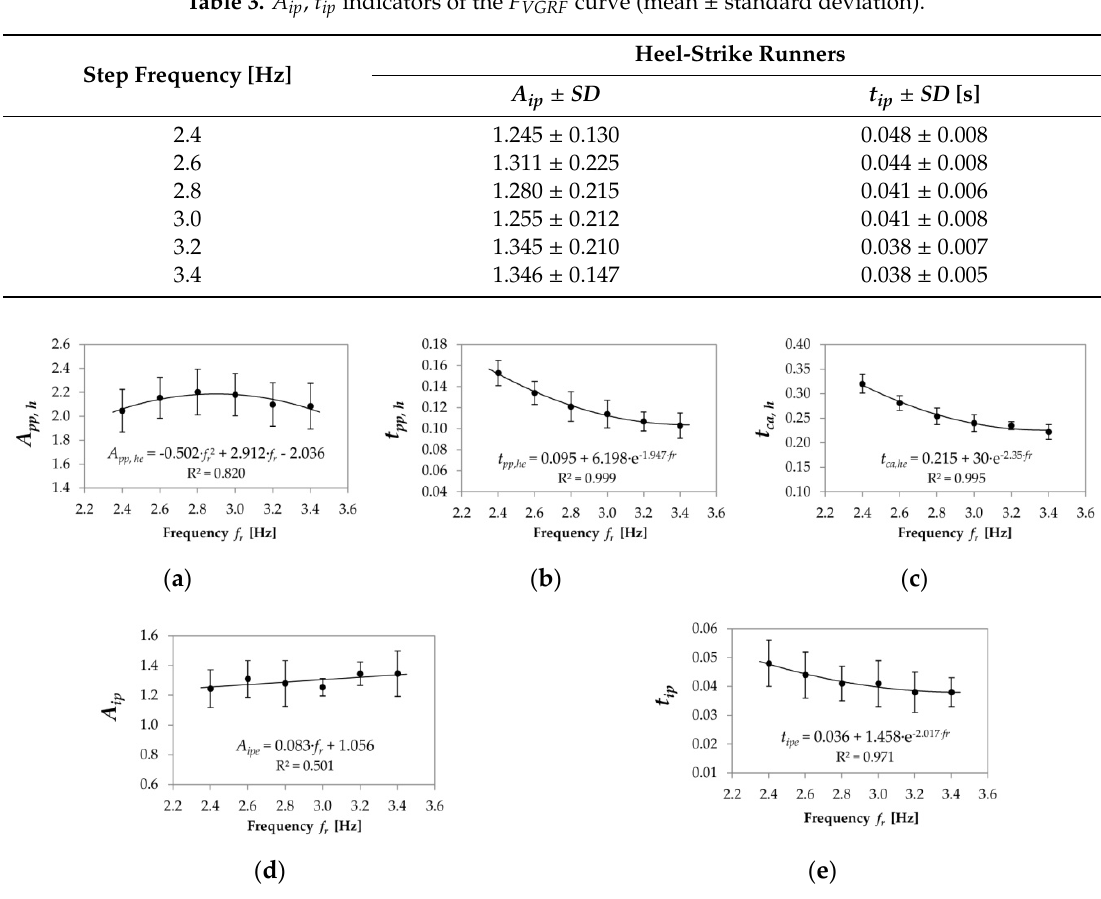
Table 3. A ip , t ip indicators of the F VGRF curve (mean ± standard deviation).